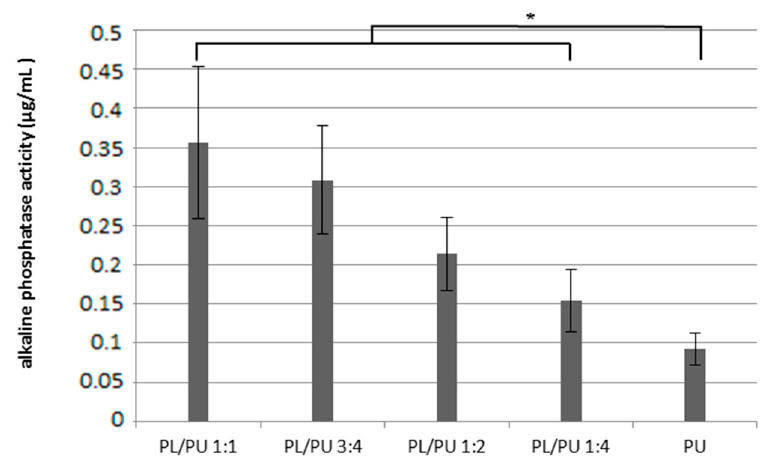
Figure 5. Alkaline phosphatase activity expressed in 7F2 culture on polyurethane composite 3 days after seeding ( n = 5) (* p > 0.05).